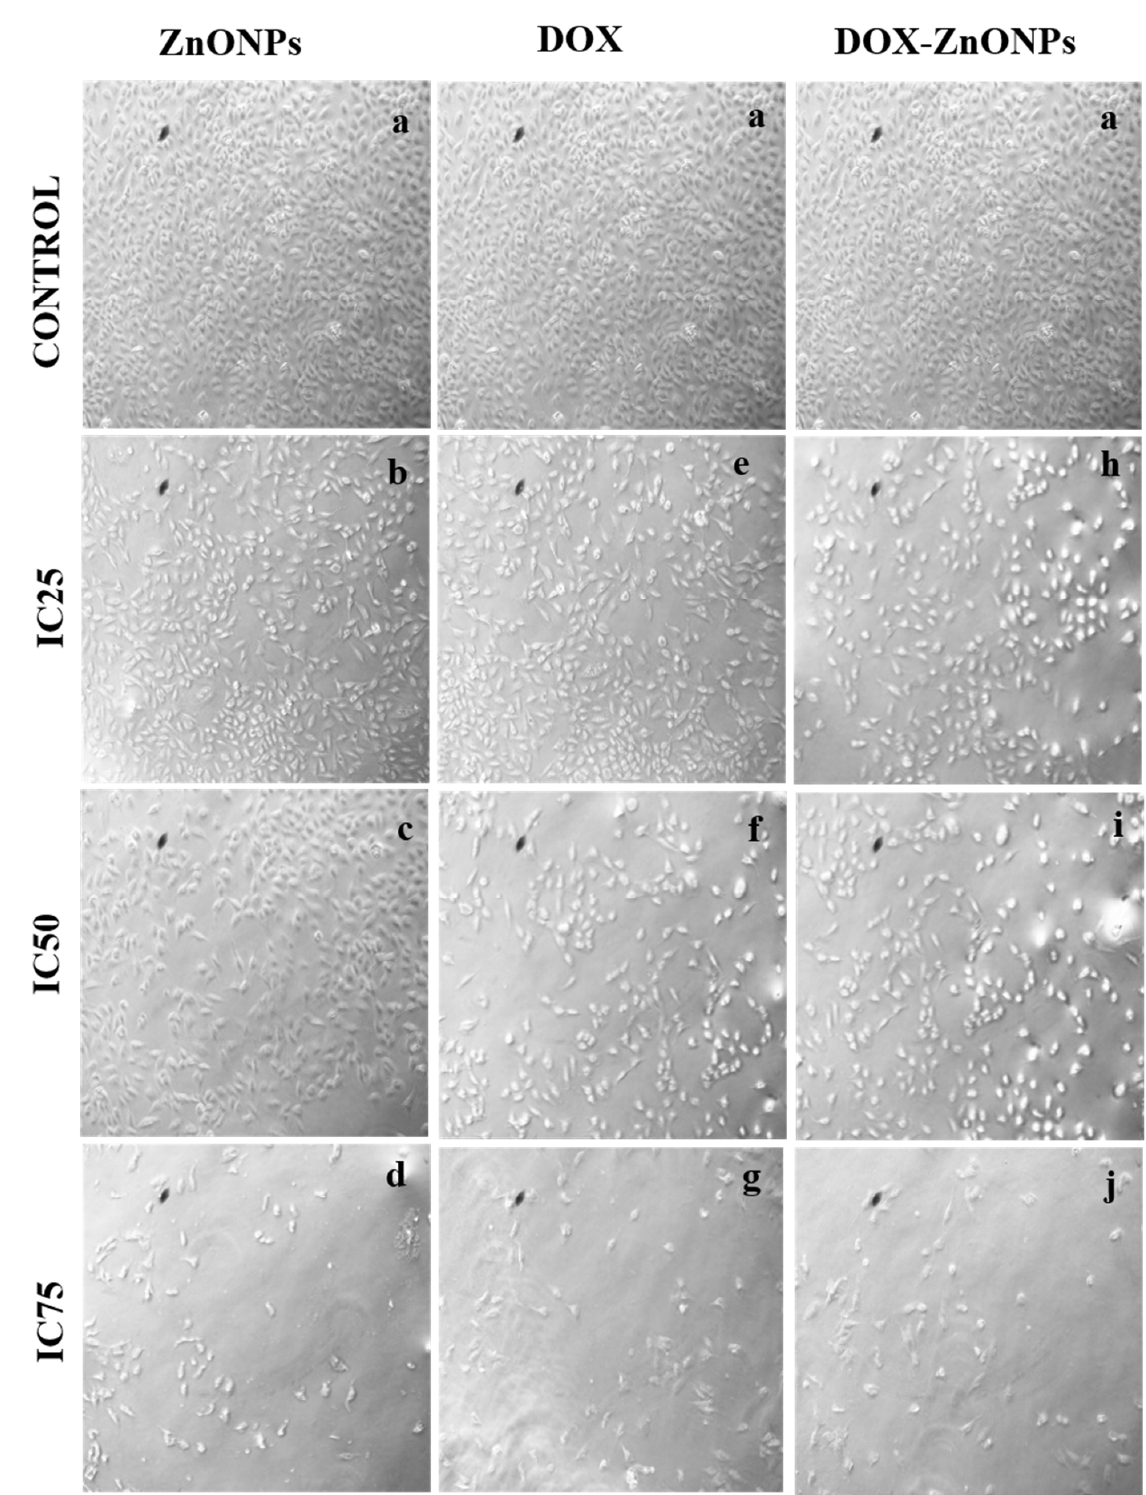
Figure 7. Cytomorphological images of A549 cells treated at IC25 [(b) ZnONPs 27.83 μ g/mL; (e) DOX 0.27 μ g/mL; (h) DOX-ZnONPs 0.079 μ g/mL], IC50 [(c) ZnONPs 65.3 μ g/mL; (f) DOX 0.56 μ g/mL; (i) DOX-ZnONPs 0.34 μ g/mL] and IC75 [(d) ZnONPs 70.41 μ g/mL; (g) DOX 0.72 μ g/mL; (j) DOX-ZnONPs 0.69 μ g/mL] concentrations. Vehicle control group image is shown as “a”. Images shown are representative of three independent experiments.